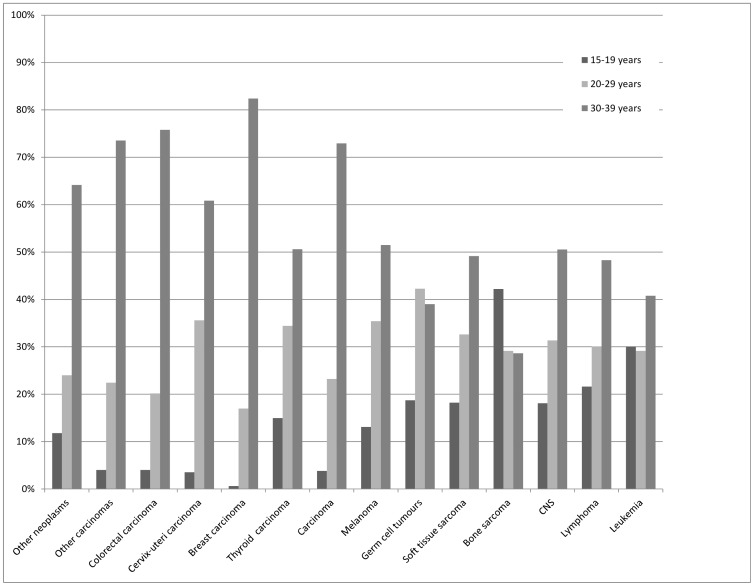
Distribution of each diagnostic groups and selected carcinomas displayed by age group.